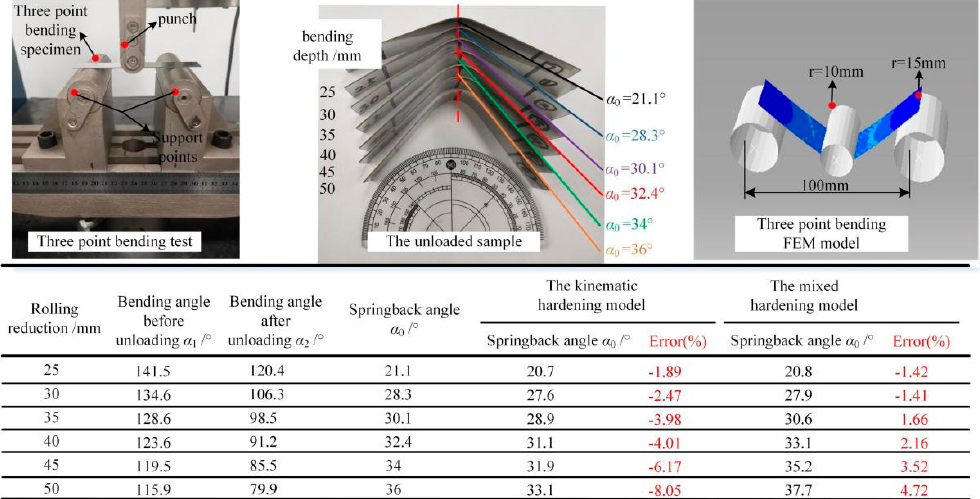
Figure 15. Comparison of the FEM results and the experimental results.